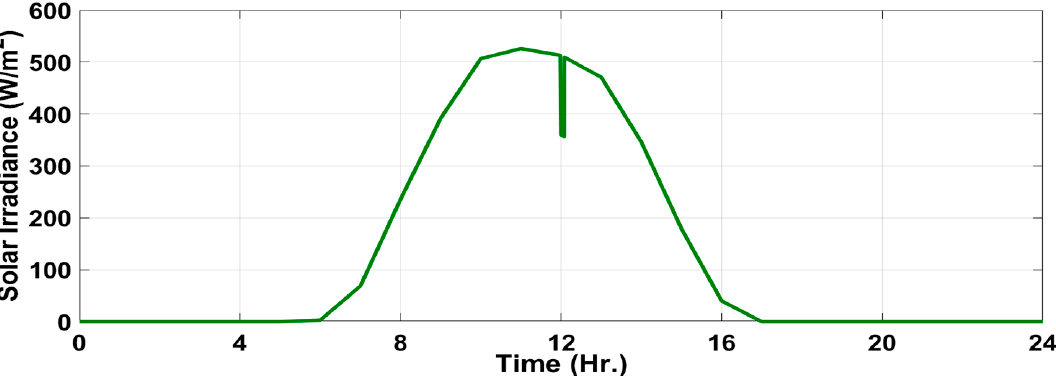
Energies 2023 , 16 , x FOR PEER REVIEW Figure 5. Solar irradiance of the PV system. Figure 5. Solar irradiance of the PV system.